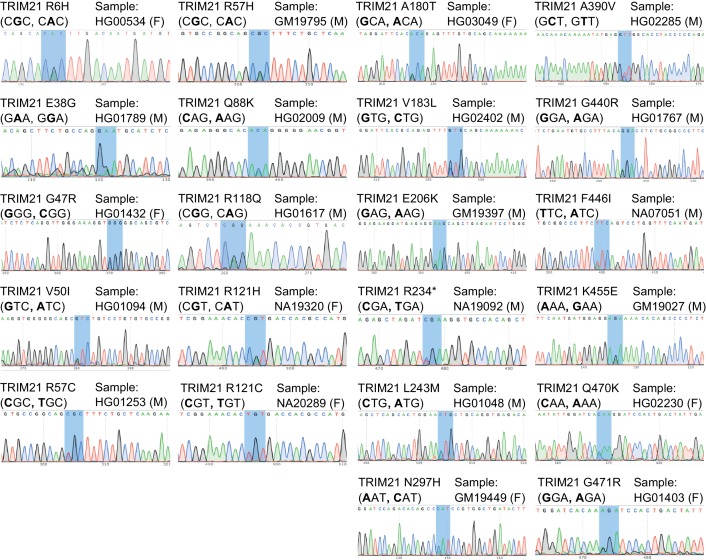
Sanger sequencing chromatograms of the TRIM21 gene in LCLs.Codons with heterozygous mutation are highlighted in blue.